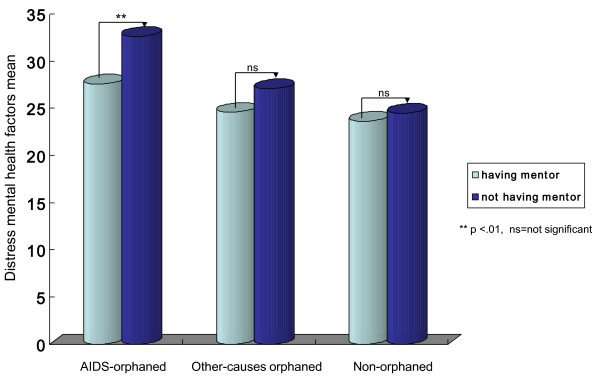
ANOVA of having/not-having a natural mentor for each of the 3 groups showing significant higher distress mental health factors in AIDS-orphaned children without natural mentors.